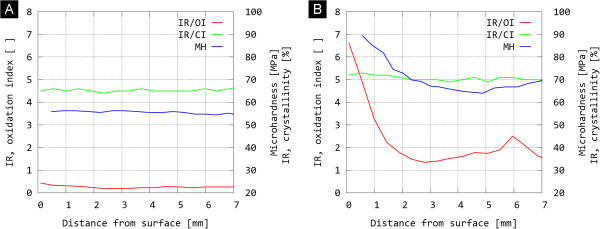
Typical oxidation index profiles, crystallinity profiles and microhardness profiles of (A) explanted UHMWPE liner with lower oxidation damage – sample L2 and (B) explanted UHMWPE liner with very high oxidation damage – sample L4.